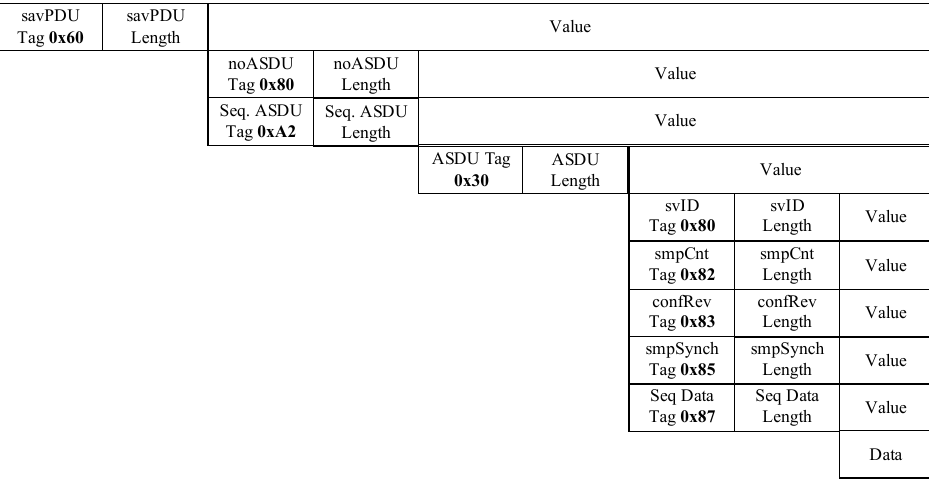
Figure 3. Description of IEC 61850-9-2 Sample Values payload fields.